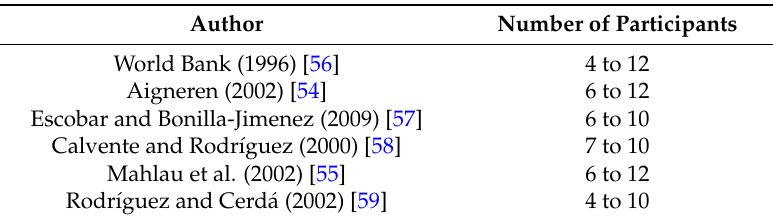
Table 1. Number of participants in focus